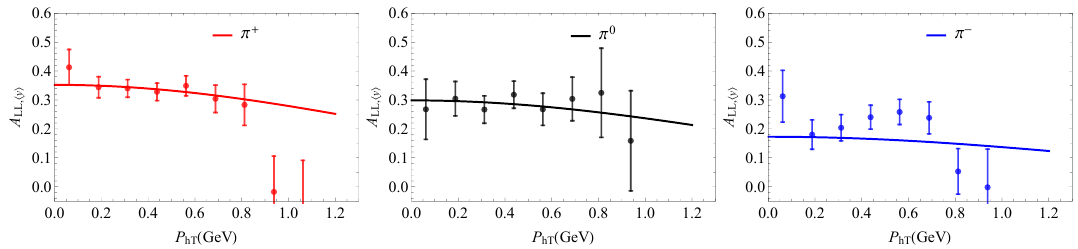
Figure 5. A as function of P hT vs. JLab data [126] for (cid:25) + , (cid:25) 0 , (cid:25) (cid:0) . The solid lines are our LL; h y i results for the mean values of kinematical variables h x i = 0 : 25, h z i = 0 : 5, and h Q 2 i = 1 : 67 GeV 2 . The de(cid:12)nition of the asymmetry used by the JLab experiment [126]